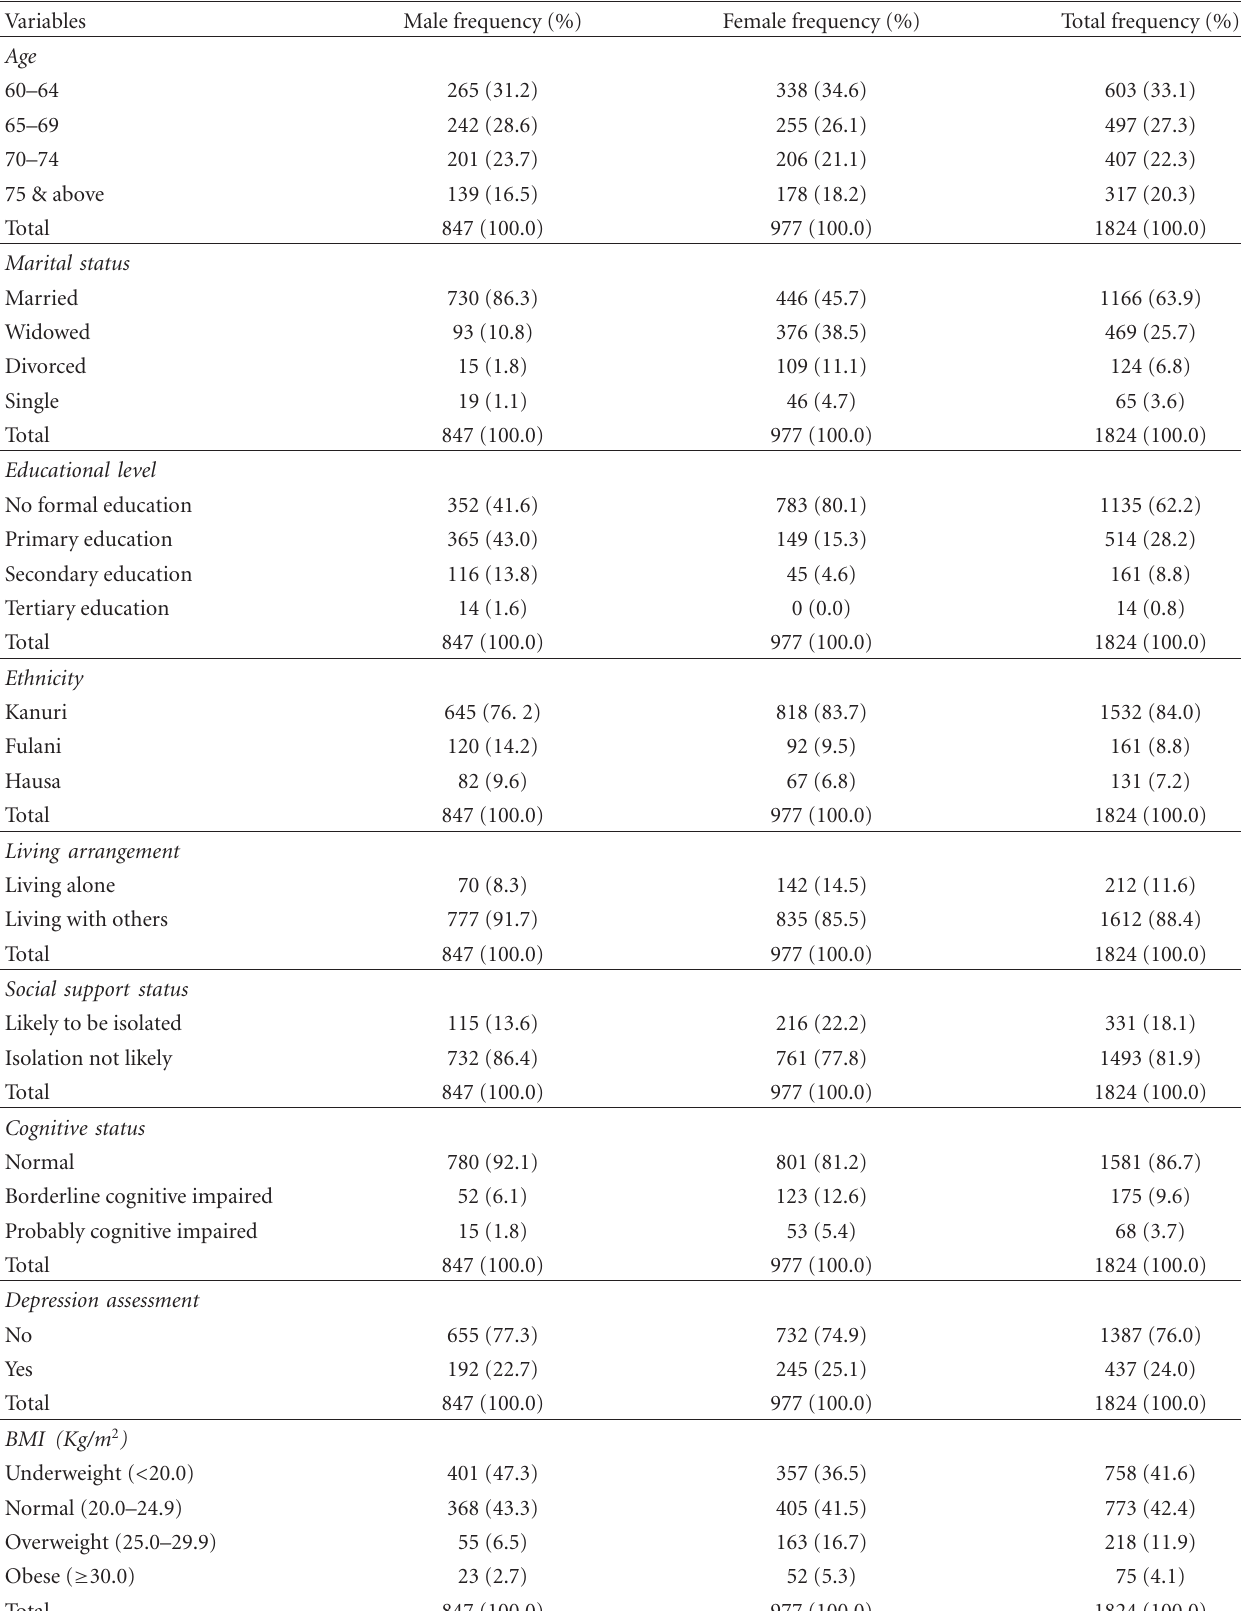
Table 1: Respondents sociodemographic and health related variables by